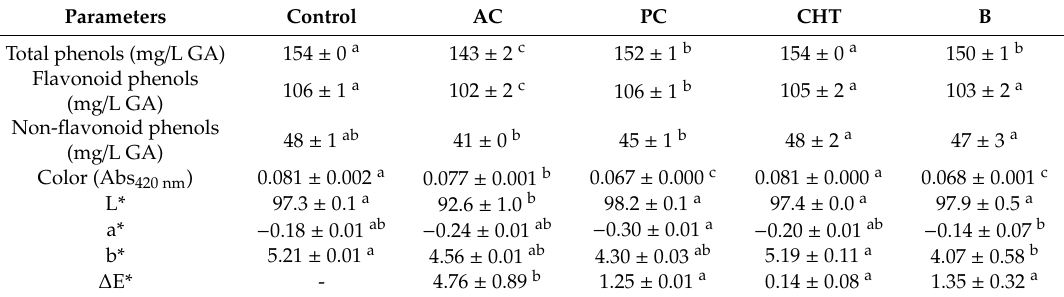
Table 2 (for white wine) and Table 3 (for red wine). White wine color (Abs 420 nm ) decreased significantly with the application of all fining agents, except with chitosan. Bentonite and potassium caseinate were the fining agents that resulted in a lower white wine color (Table 2). Table 2. E ff ect of fining agents on phenolic compounds, color (Abs 420 nm ), and chromatic characteristics of white wine.